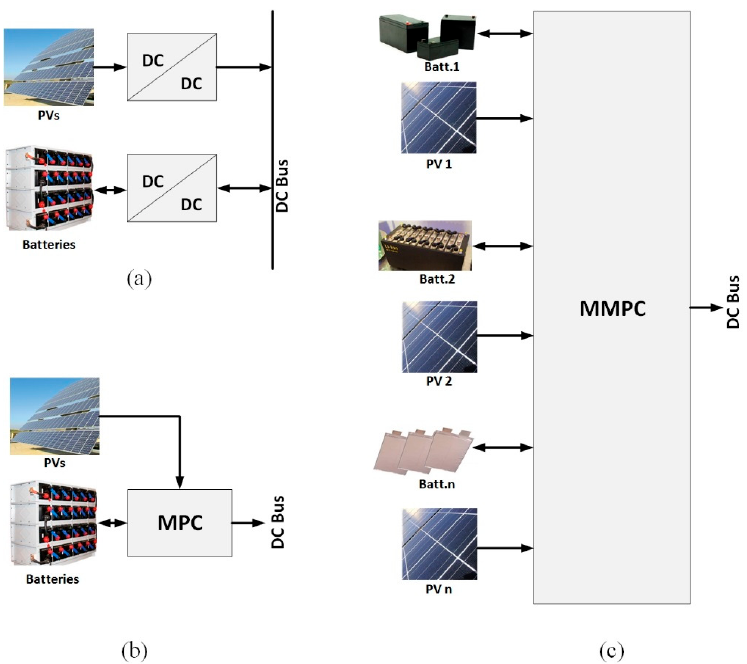
Figure 1. Power system structure with ( a ) multiple single DC-DC converters; ( b ) Conventional centralized multiport DC-DC converter; ( c ) proposed modular multiport DC-DC converter.